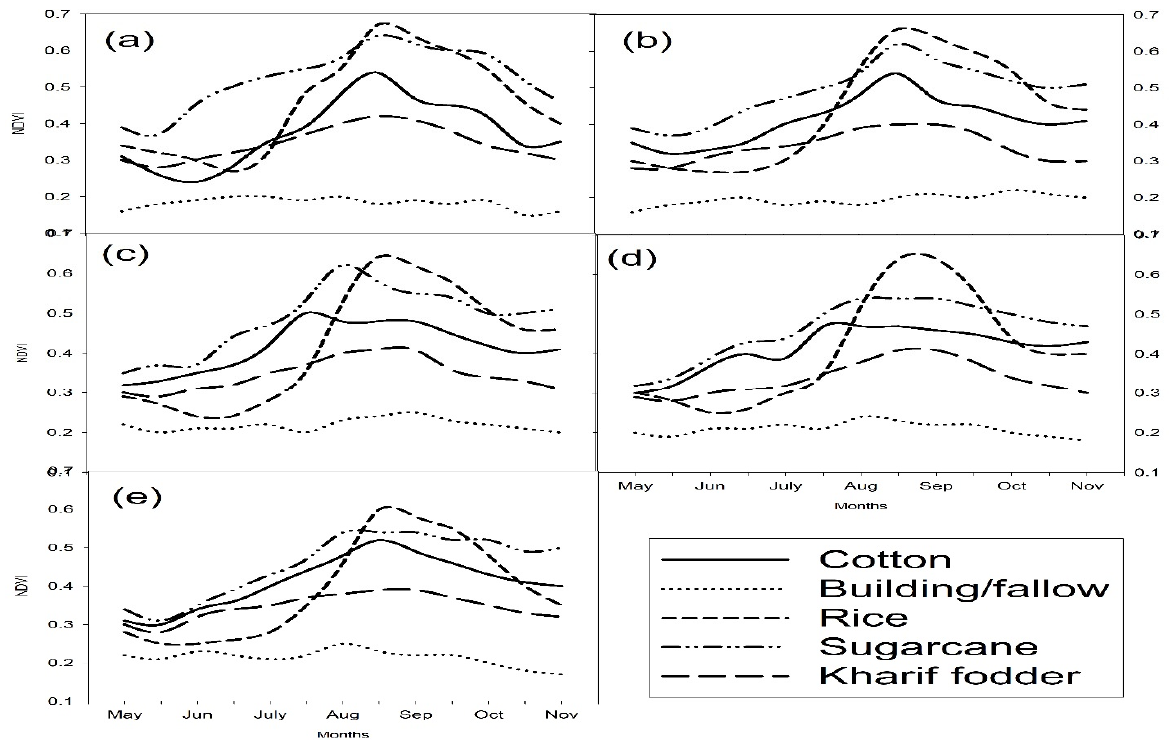
Atmosphere 2022 , 13 , 1609 12 of 20